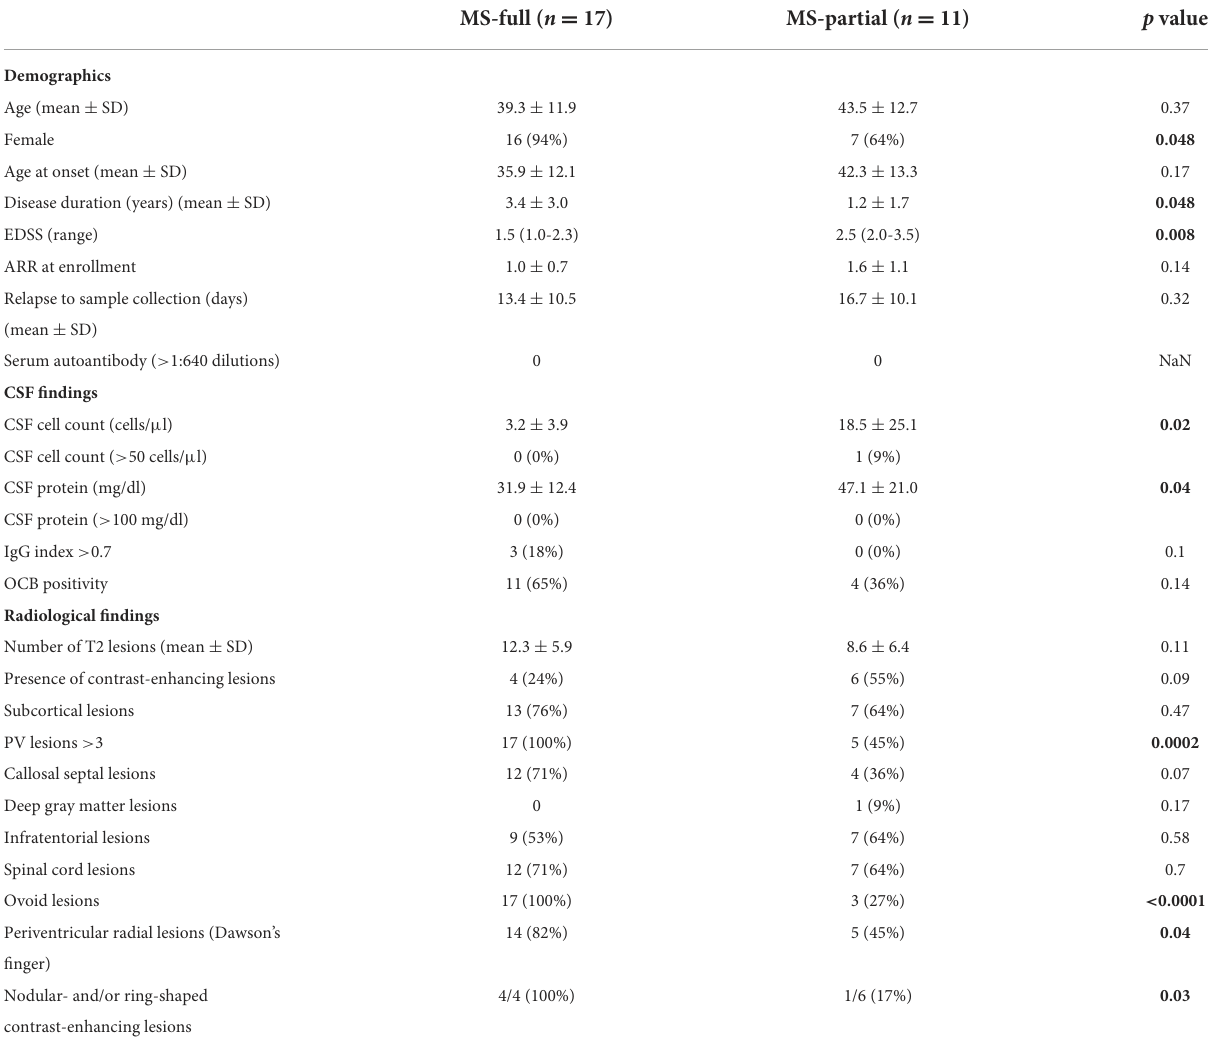
TABLE 3 Demographic features between MS-full and MS-partial